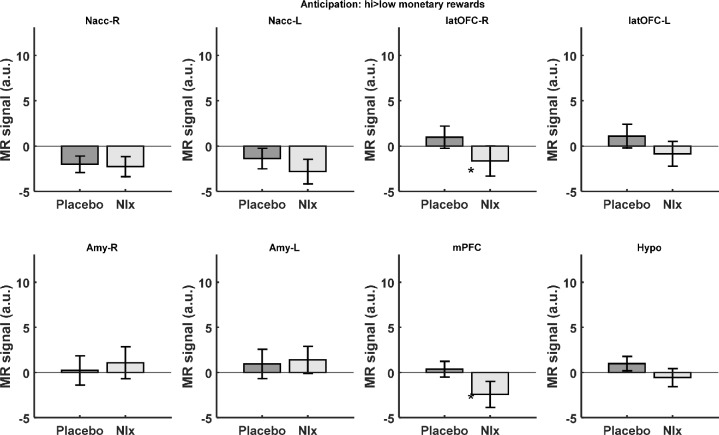
Region of interest contrasts of brain activity for high versus low monetary reward anticipation for placebo and naloxone treatment (*p<0.05, uncorrected).